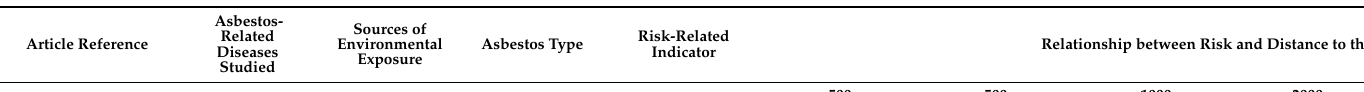
Table 2. Summary of distances used in the current